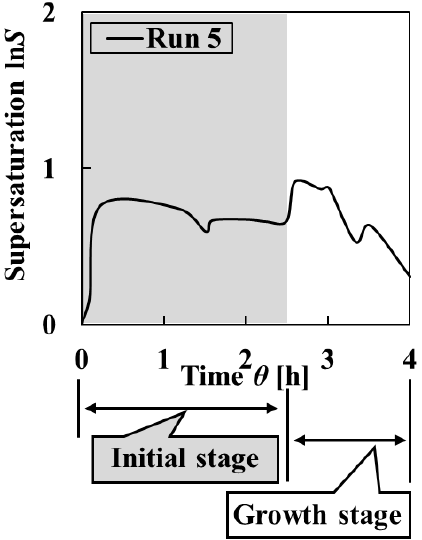
Figure 11. Change in the supersaturation calculated from the measured pH and L-Asp concentration of the solution in Run 5.